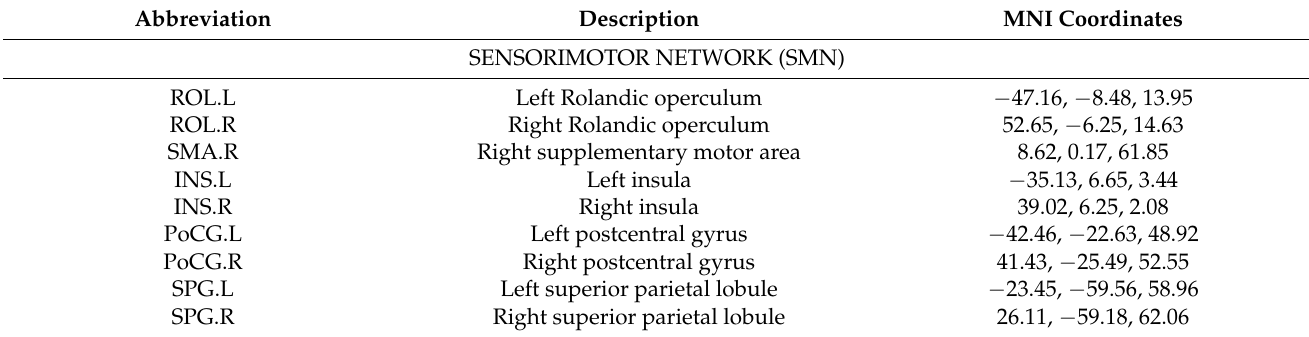
Table A1. Summary of each parcellation’s abbreviation, description, and MNI